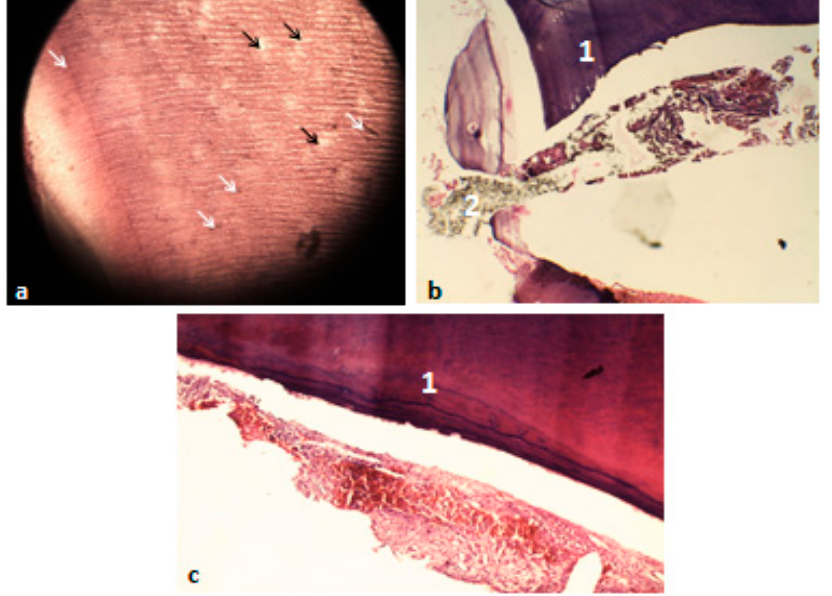
Figure 4. Histologic microphotographs of extracted teeth (root treated in two sessions with Cupral). The samples were processed, stained with Hematoxylin and Eosin (H&E) and cut in longitudinal section. ( a ) There is an impregnation of the dentinal canals with copper crystals along their entire length, highlighted in light brown color (white arrows). The free, unimpressed intracanal matrix is seen in white color (black arrows). ( b ) Apical section: Intensive impregnation with copper sulfite of the endodontic canal wall, where a homogeneous penetration is observed. Copper crystals in the dentinal tubules along the entire length of the root canal walls are also evident (1). Copper hydroxide precipitation at the root apex highlighted by the dark green color (2). ( c ) The canal wall is intensely impregnated with copper sulfite; a massive impregnation of the dentinal canals is also observed (1). Representative images are shown in a magnification of 400×.